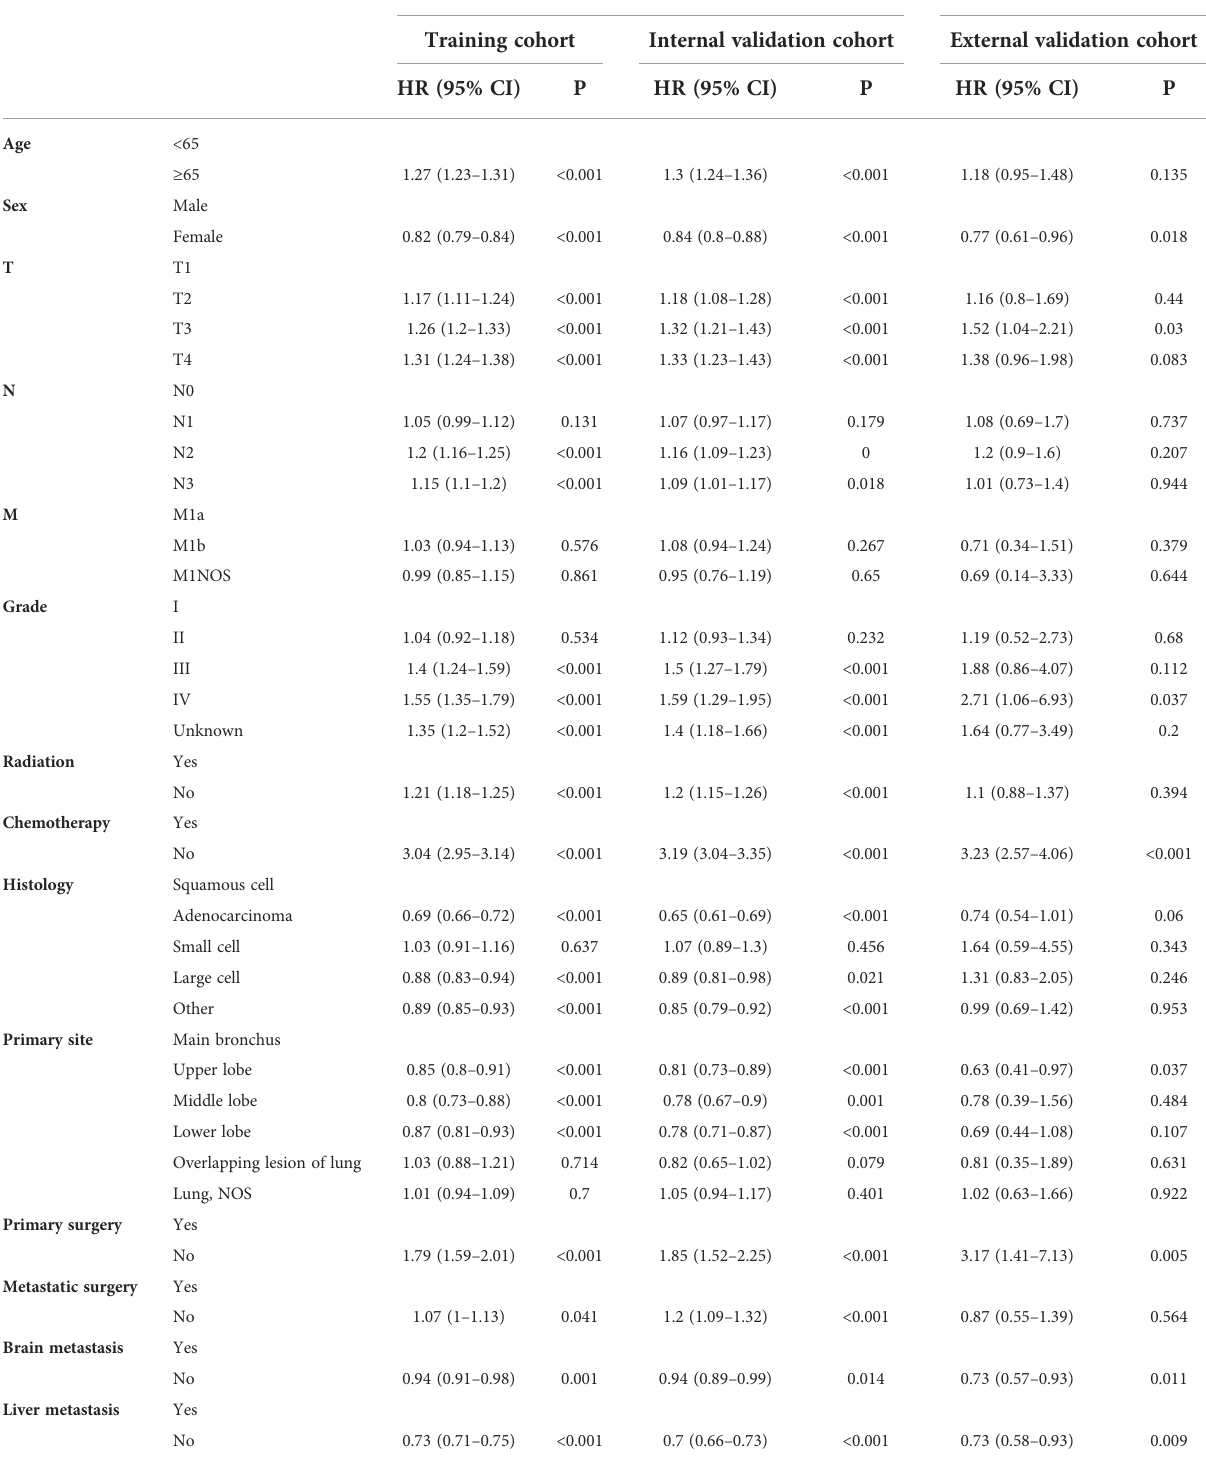
TABLE 2 Univariate Cox regression model in the training, internal validation, and external validation cohorts of overall survival (OS) (N,